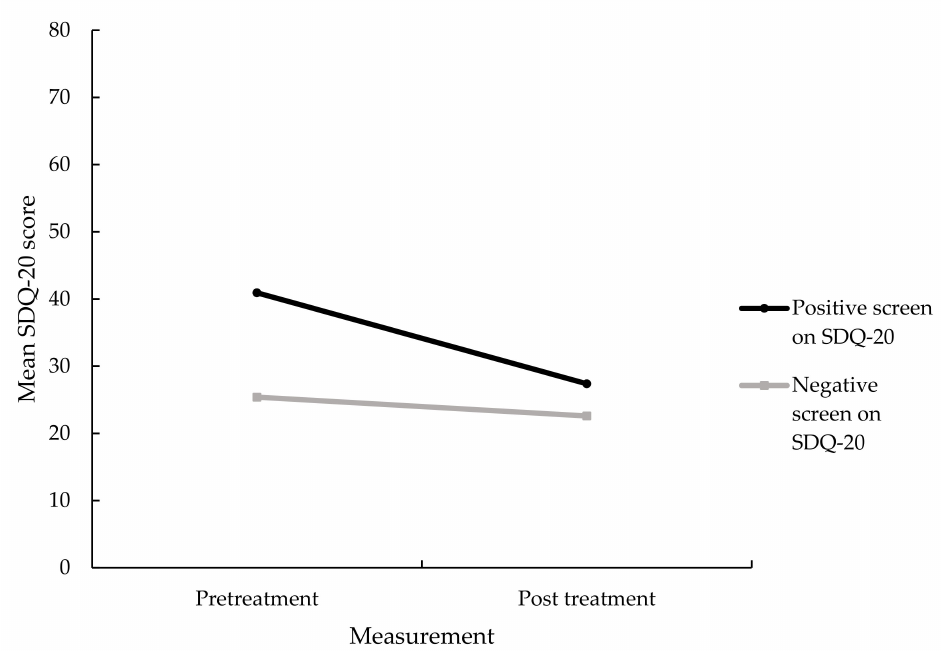
Figure 4. Mean SDQ-20 scores for those with and without a positive screen on the SDQ-20, n = 219. SDQ-5 scores decreased significantly over the treatment days, F (3.07, 603.82) = 53.97, p < 0.001, partial η 2 = 0.22. Additionally, a significant main effect of group was found, F (1, 197) = 21.90, p <0.001, partial η 2 = 0.10, indicating that those in the positive screen